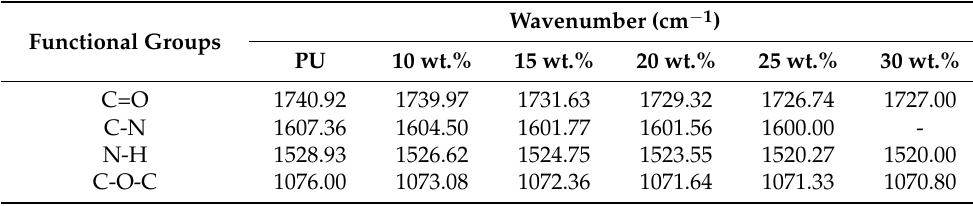
Table 2. FTIR absorption peak of PU and PU/LiClO 4 .